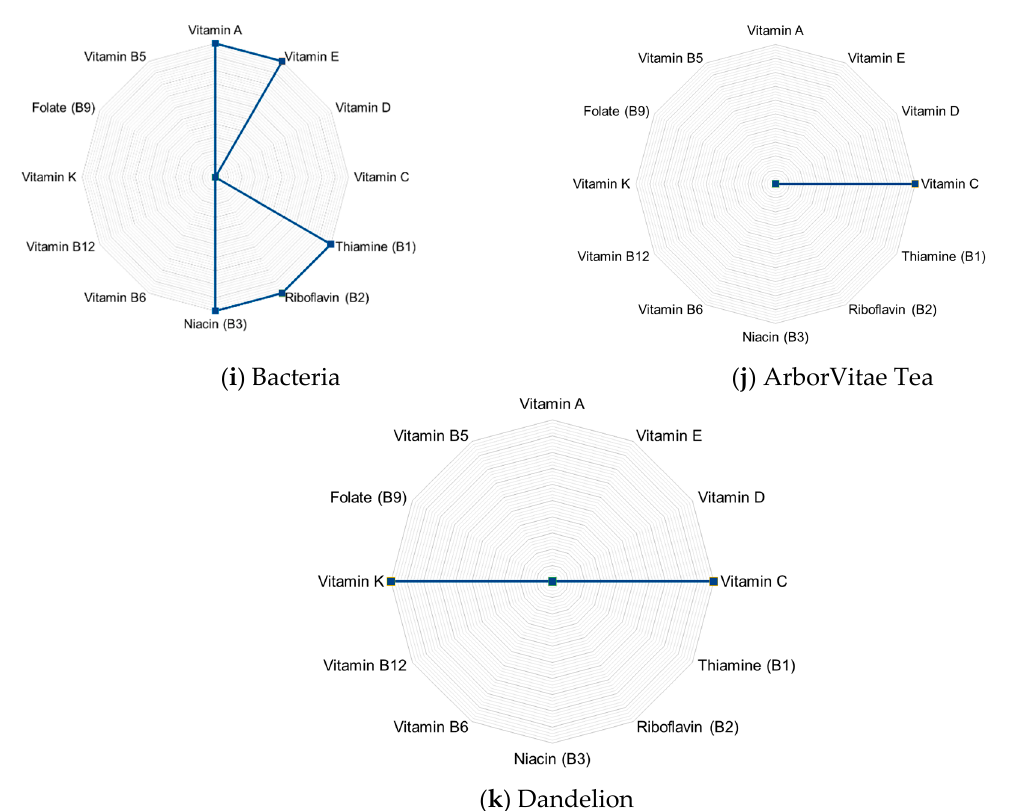
Figure 2. Micronutrients of 100% diet from single alternative food with EFSA percentages of vitamin A, E, D, C, B1, B2, B3, B6, B12, K, B9, and B5: ( a ) Tuna, ( b ) Beef, ( c ) Liver, ( d ) Chicken, ( e ) Shiitake mushrooms, ( f ) Oyster mushrooms, ( g ) Milk, ( h ) Eggs, ( i ) Bacteria, ( j ) ArborVitae tea, and ( k ) Dandelion. Please note that ArborVitae tea and dandelion did not have full nutrient profiles. Radial scale by 20% increments.